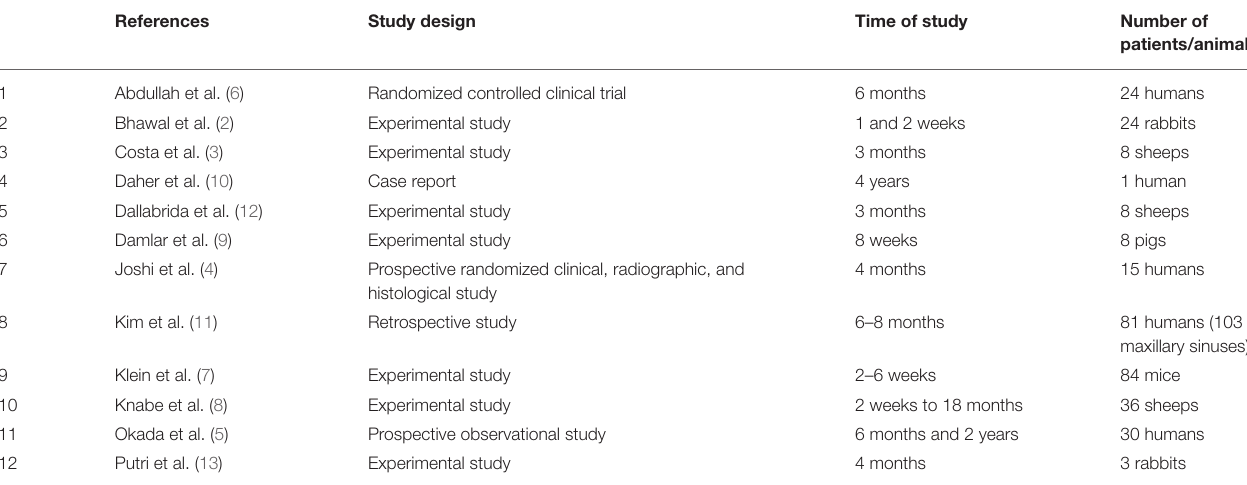
TABLE 1 | Articles included in the systematic review showing authors, type of study, observation time, and number of patients or animals used in the